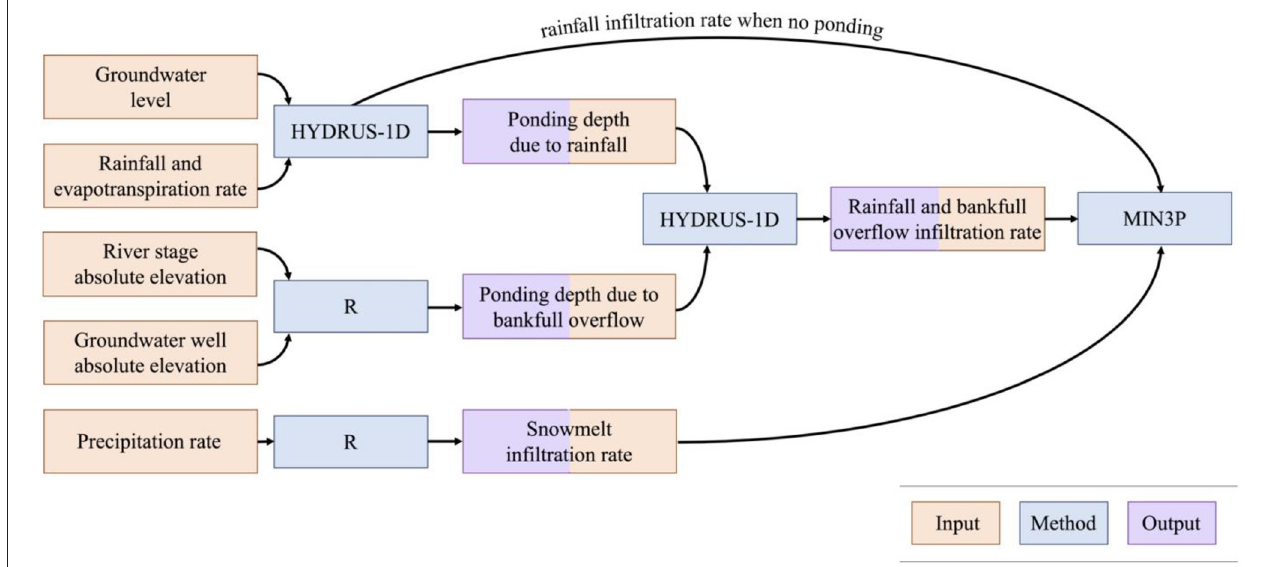
FIGURE 5 | Analysis workflow to obtain specified flux surface boundary for input into